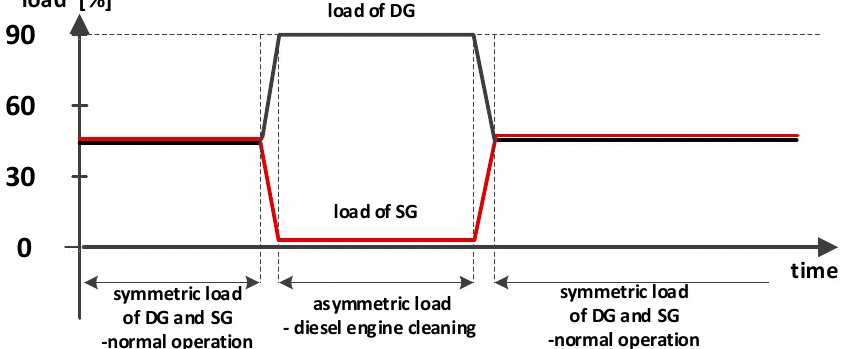
Figure 2. The idea of cleaning the diesel engine of a diesel generator (DG) set.